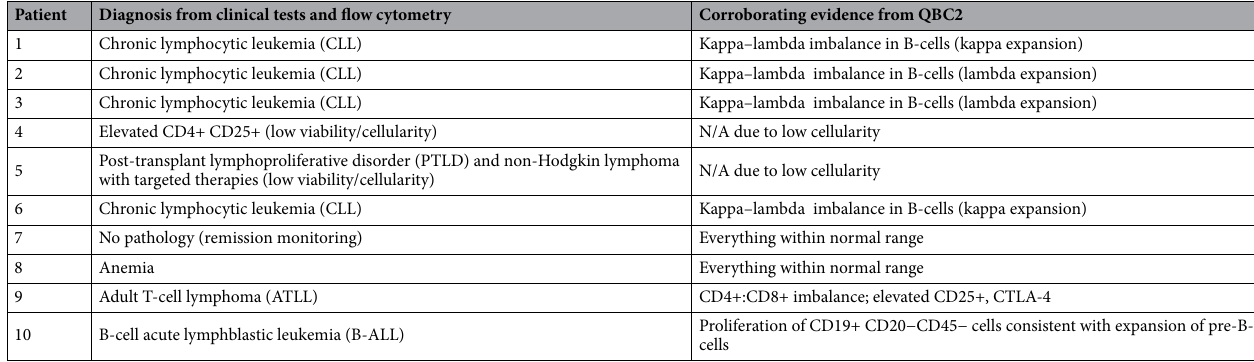
Table 1. Patient diagnosis and monitoring information. Diagnostic information obtained from clinical testing including flow cytometry was compared against evidence obtained from QBC2 to support diagnostic takeaways.